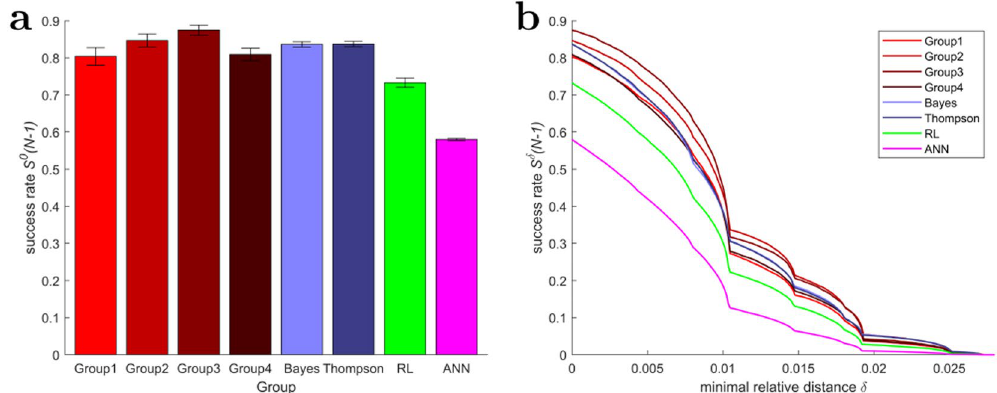
Figure 2. Success rate of group decisions. ( a ) Proportion of time points where actions steered the cursor closer to the target for the four human groups and the four computational models. Error bars indicate 99% confidence intervals. ( b ) Success rate as a function of the minimally required improvement δ of the cursor displacement relative to the target. The improvement threshold is measured as a dimensionless fraction of display size and ranges between 0 and . 0 028 . The minimum value naturally corresponds to the case where the cursor is not moved at all, the maximum value corresponds to the best case improvement. Large improvements (e.g. 0 02 ≥ . ) are